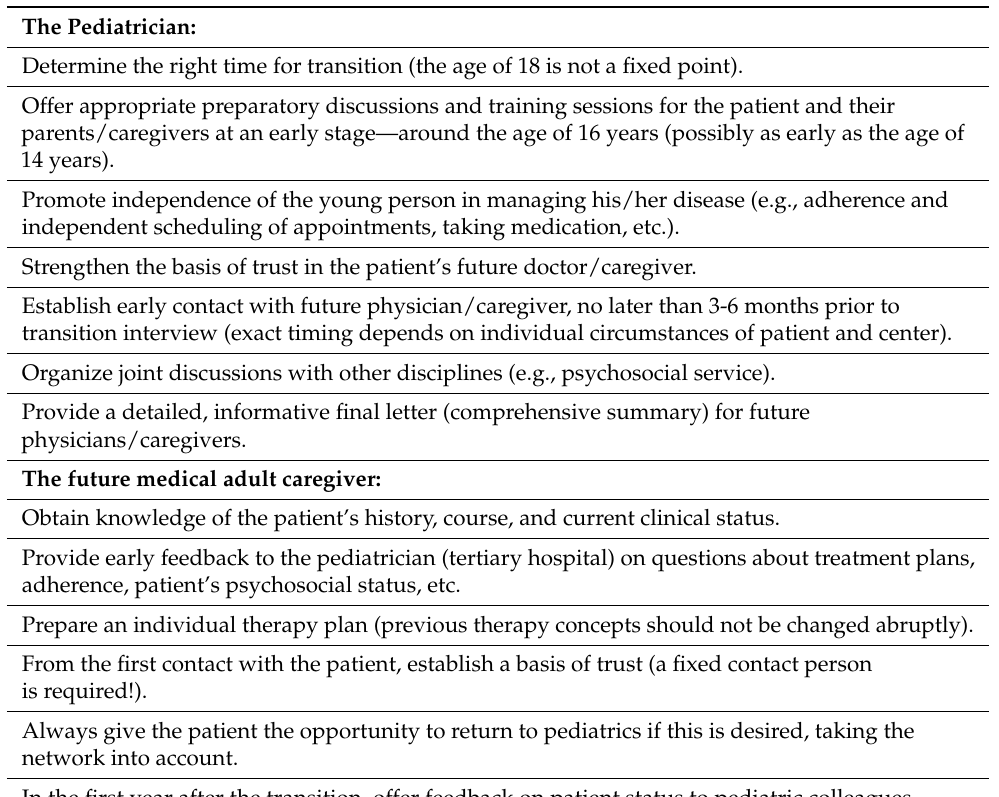
Table 1. Individual task